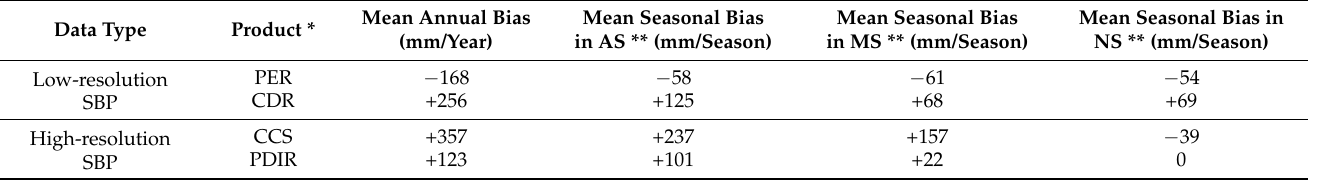
Table 3. The summary of the annual performances of PVEs (January 2003–May